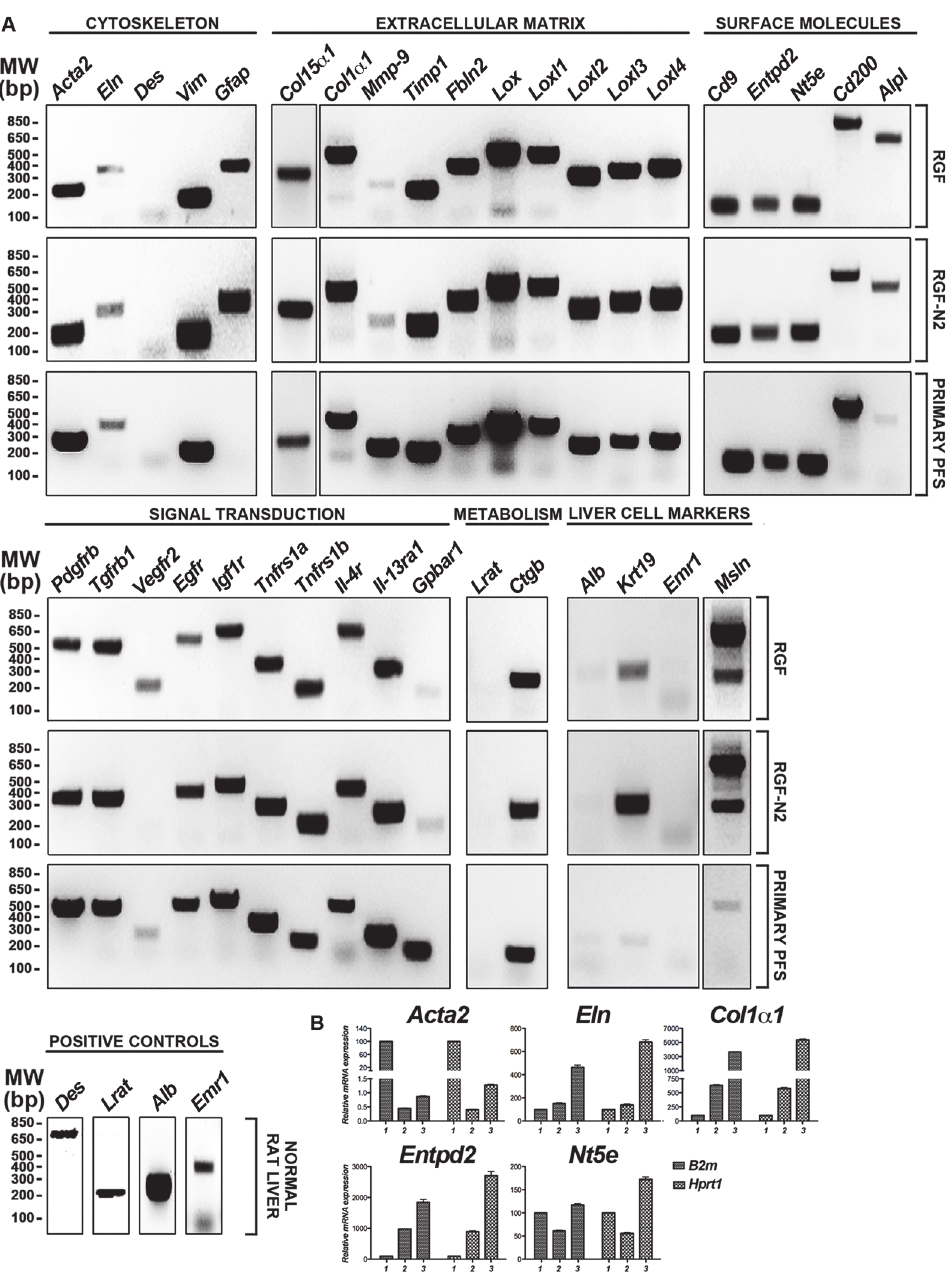
Fig 1. Phenotypic characterization of immortalized rat portal fibroblastic RGF and RGF-N2 cell lines by RT-PCR. (A) Cultured primary isolated aPF (8 days) and immortalized rat PF RGF and RGF-N2 cDNA samples were used as templates in PCR reactions with primers specific to transcripts of several fibrogenic genes in liver myofibroblasts (see Table 1 for gene list and accession numbers). RGF and RGF-N2 cell lines express classical α SMA ( Acta2 ), type I collagen α 1 ( Col1 α 1 ) liver myofibroblast gene products, along with PF-derived elastin ( Eln ), type XV collagen α 1 ( Col15 α 1 ), and Ntpdase2 ( Entpd2 ) myofibroblast markers, also found in primary culture-activated portal myofibroblasts. Both cell lines are devoid of HSC-derived myofibroblastic desmin ( Des ) and lecithin-retinol acyl transferase ( Lrat ) markers. Rat normal liver or brain cDNA was used as positive control, when no PCR amplicon was detected (not shown). Nuclease-free water was used as negative control (not shown). MW , molecular weight; bp , base pairs . (B) Cultured primary isolated aPF (8 days, 2 primary cell isolations) and immortalized rat PF RGF (passages #61 and #64) and RGF-N2 cDNA (passages #54 and #55) samples were used as templates in quantitative PCR reactions with probes specific to transcripts of fibrogenic Acta2 , Eln , Col1 α 1 , Entpd2 , and Nt5e genes in liver myofibroblasts. Housekeeping B2m and Hprt1 genes were separately used as references.